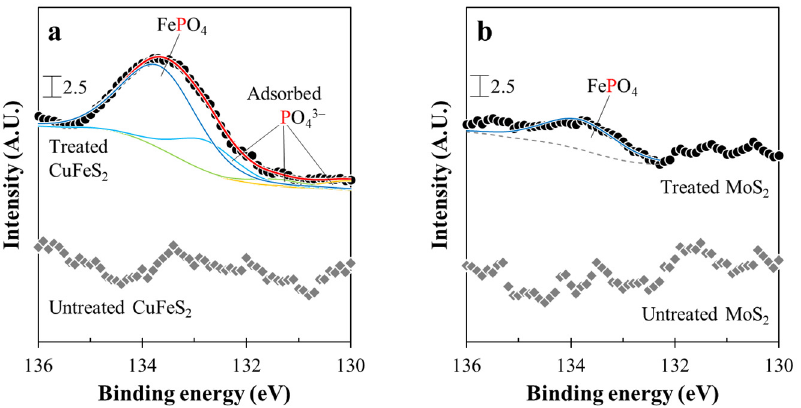
Figure 6. SEM-EDX results of molybdenite with and without microencapsulation treatment.